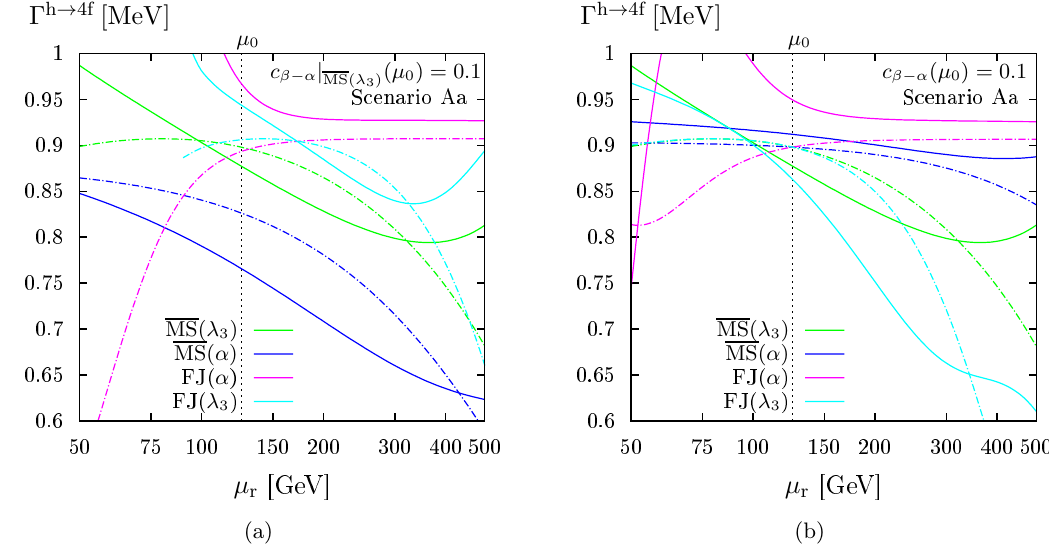
Figure 9 . Renormalization scale dependence of the decay width for h NLO EW (solid) for the benchmark point Aa using a central renormalization scale of (cid:22) 0 = M h (in contrast to (cid:12)gure 6). In (a) the input for (cid:12) and (cid:11) is de(cid:12)ned in the MS( (cid:21) 3 ) scheme and converted to the other schemes at NLO (also for the LO curves). In (b) the input for (cid:12) and (cid:11) is taken